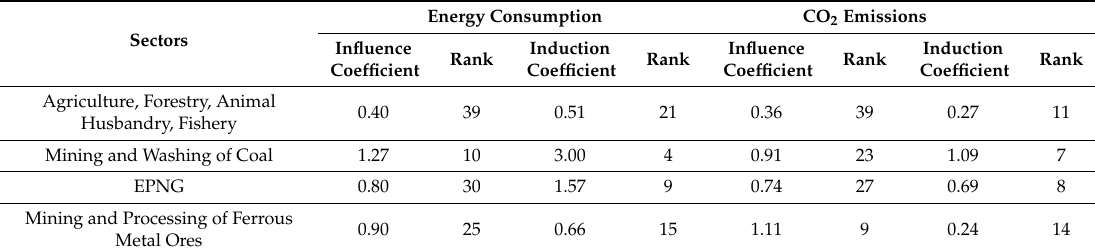
Table A1. Influence and induction coefficients of energy consumption and CO 2 emissions for all 42 economic sectors of China